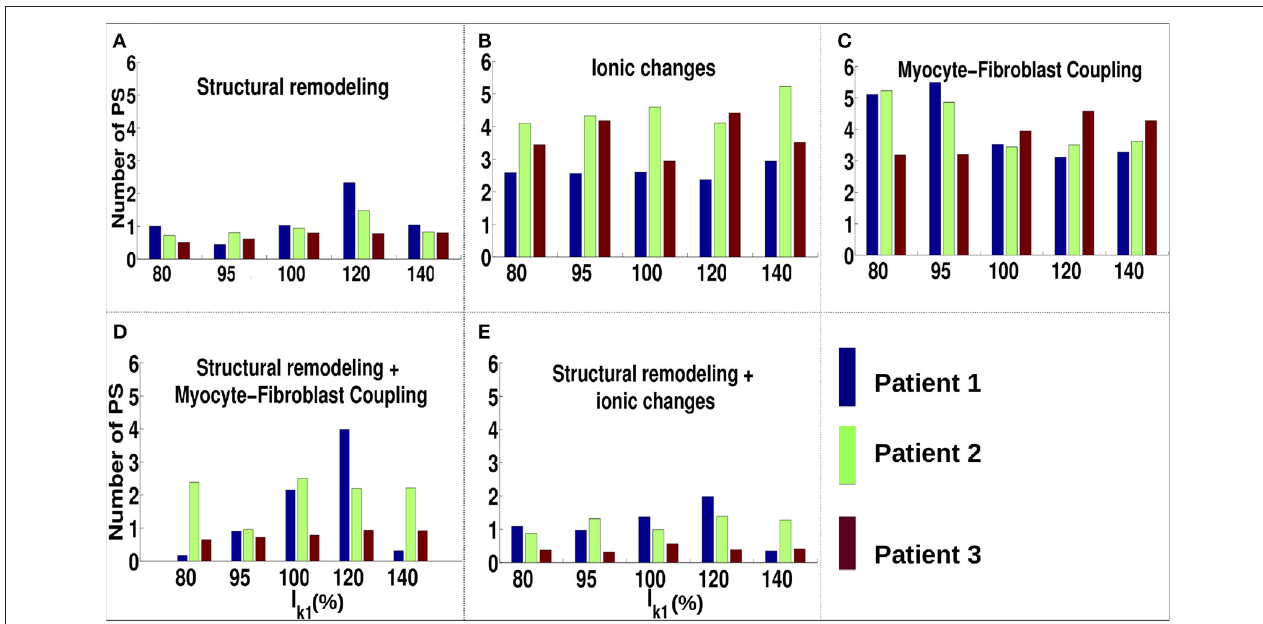
FIGURE 7 | Number of PS per time unit for IK1 conductance scaled by 80–140% for different fibrosis modeling methodologies, corresponding to: (A) structural remodeling, (B) ionic current remodeling, (C) myocyte-fibroblast coupling, (D) structural remodeling and myocyte-fibroblast coupling, (E) structural and ionic current